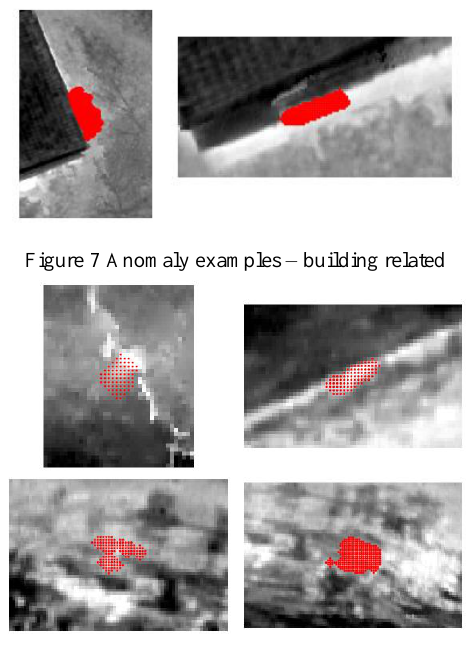
Figure 8 Anomaly examples – unknown objects